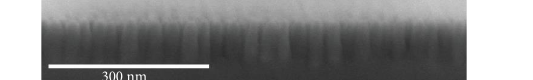
Figure 5: Scanning electron microscope (SEM) image of the cross section of “Brush Cut” morphology for sample Table 1: List of characteristic pillar/brush hair parameters for the four samples of “Brush Cut” morphology. Sample